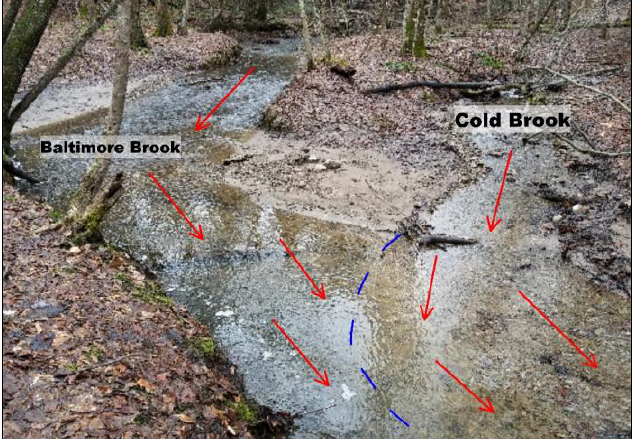
Figure 1. BBCB confluence study site with red arrows showing flow direction and blue dashed line showing the location of the shear layer (picture taken on 1 January 2019).